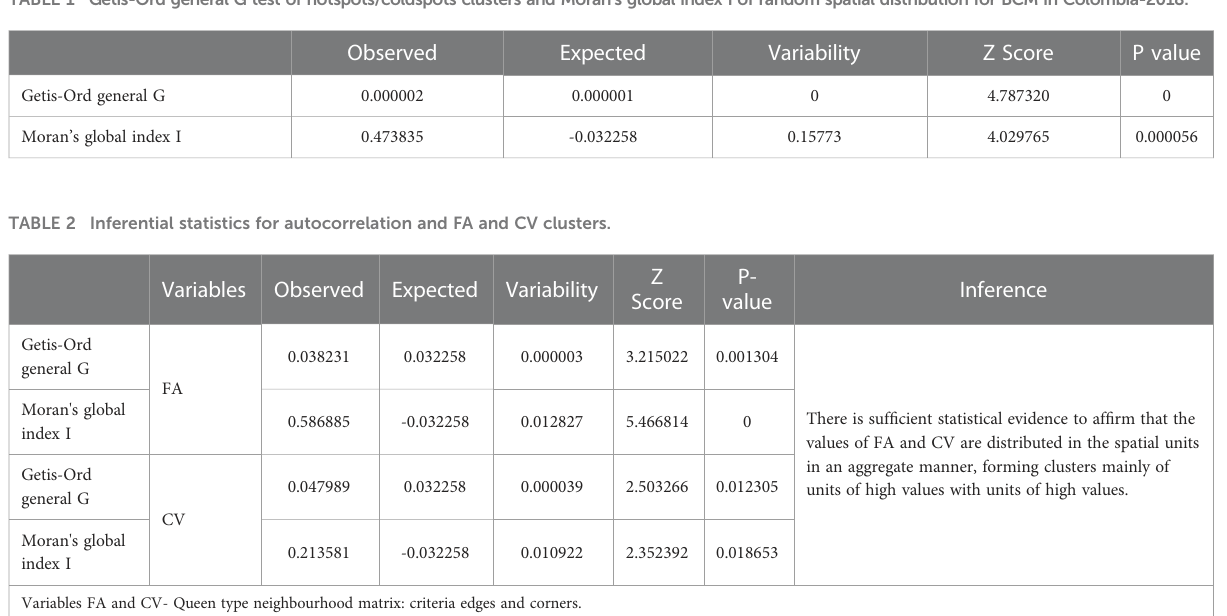
TABLE 1 Getis-Ord general G test of hotspots/coldspots clusters and Moran ’ s global index I of random spatial distribution for BCM in Colombia-2018.